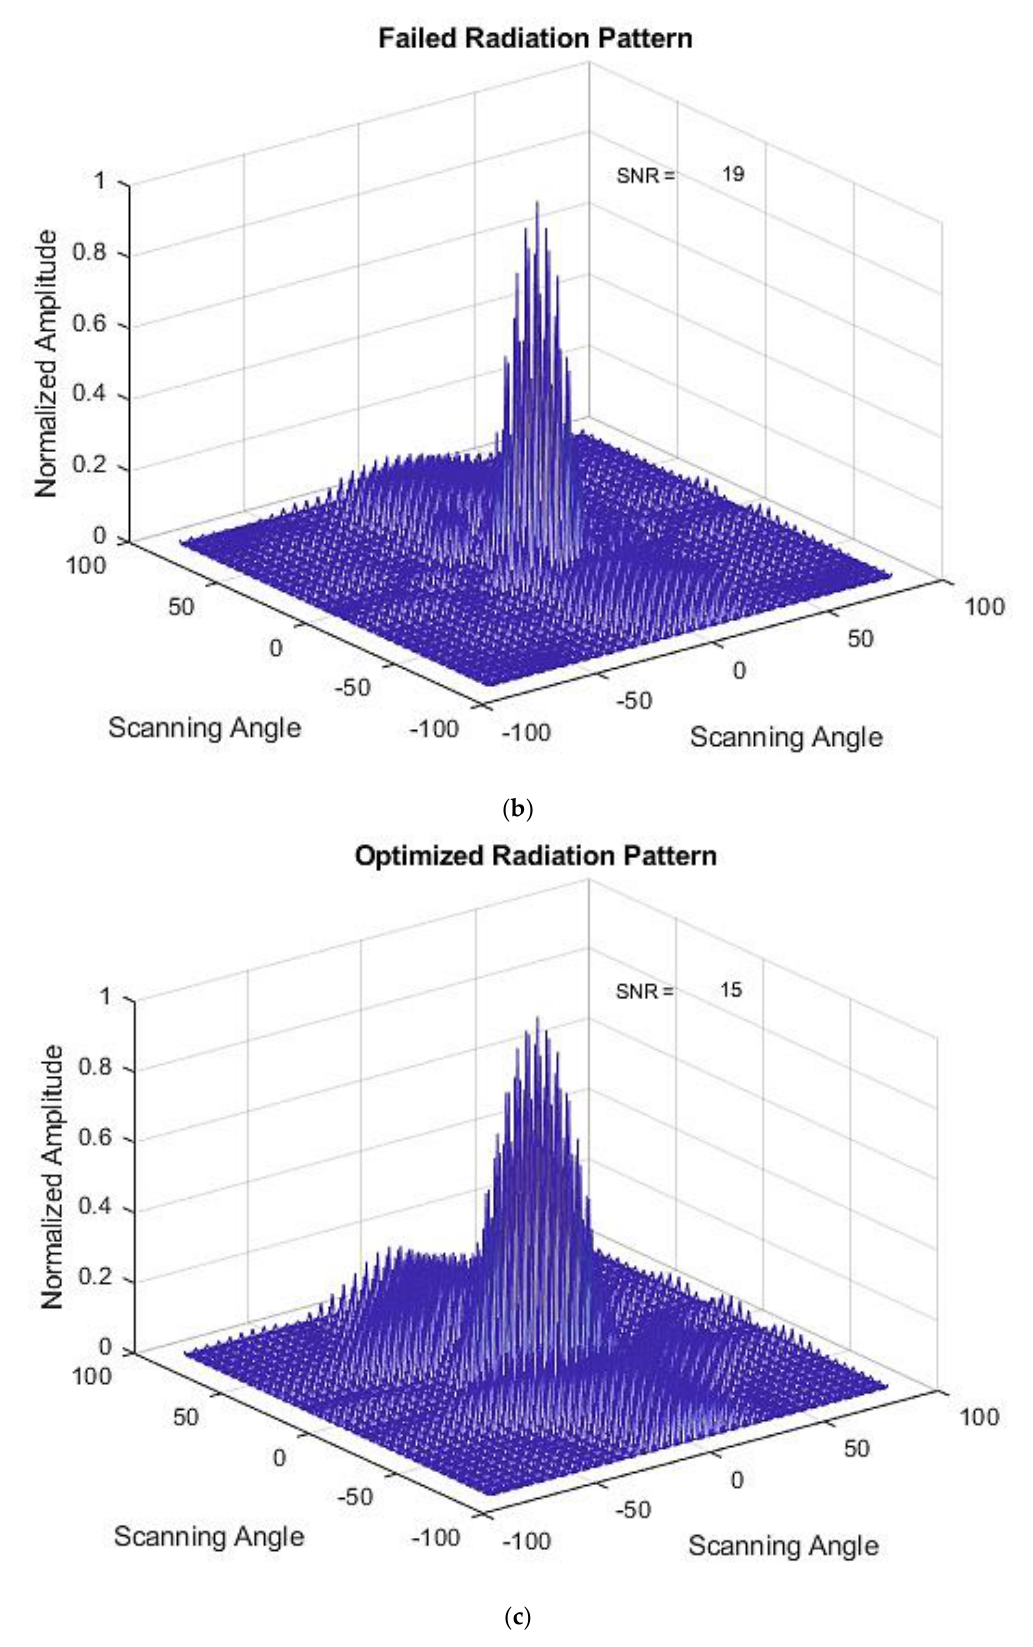
Figure 9. ( a ) Initial Radiation Pattern for the PSO method. ( b ) Failed Radiation Pattern for the PSO method. ( c ) Optimized Radiation Pattern for the PSO method.